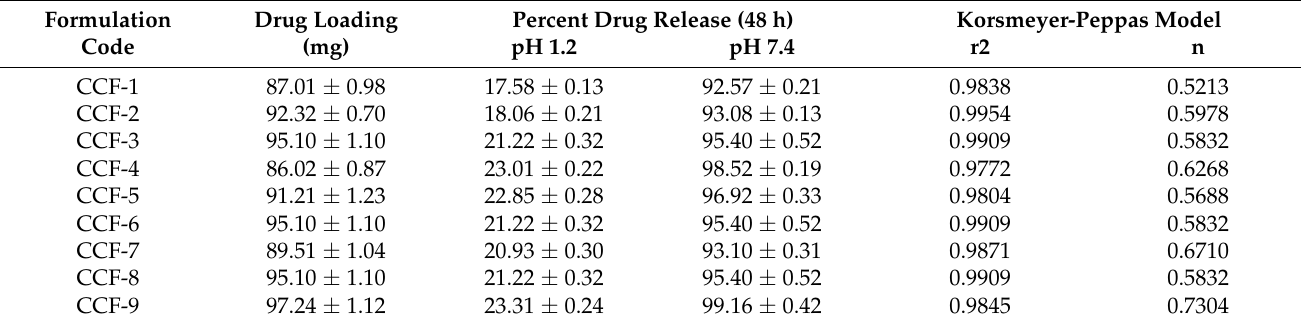
Table 1. Drug loading, percent drug release and kinetic modeling of CS/CBP-co-PAA interpenetrating network of hydrogels.